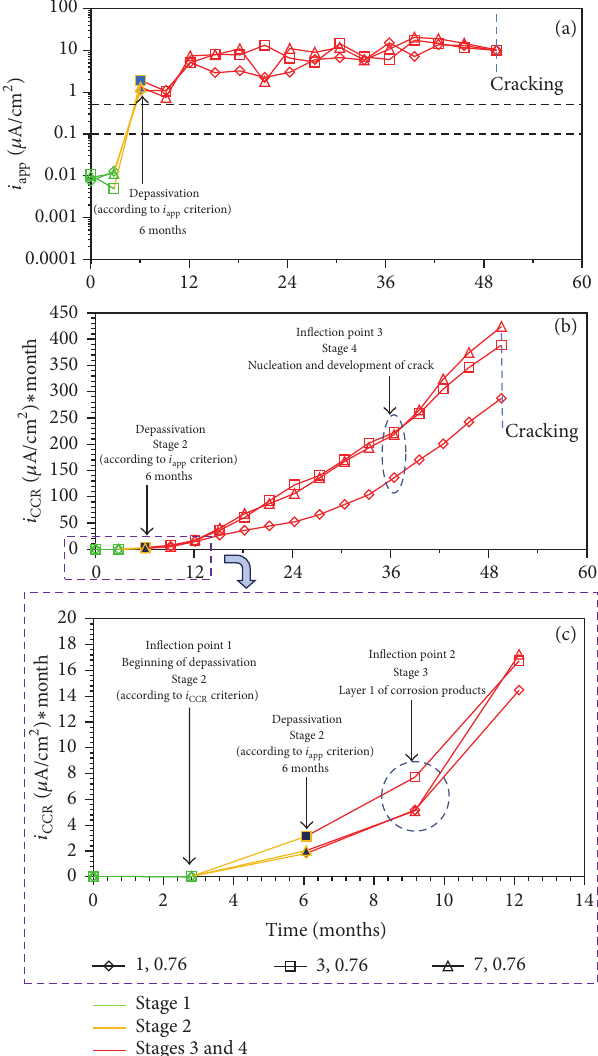
Figure 2: (a) Average apparent 𝑖 corr and (b and c) cumulative 𝑖 corr versus exposure time, w/c ratio = 0.76, and three